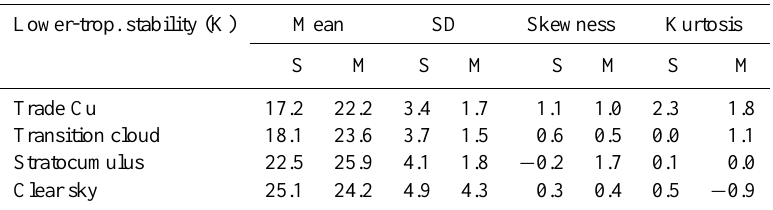
Fig. 4. Cloud-type distributions of lower-tropospheric stability for the entire 310-day data set. Panel (a) is for the AIRS/MODIS observations, and panel (b) for ERA-Interim. Table 2. Mean, standard deviation, skewness and kurtosis of AIRS-derived lower-tropospheric stability (LTS) for three marine boundary layer (MBL) cloud types and clear sky (defined in Sect.